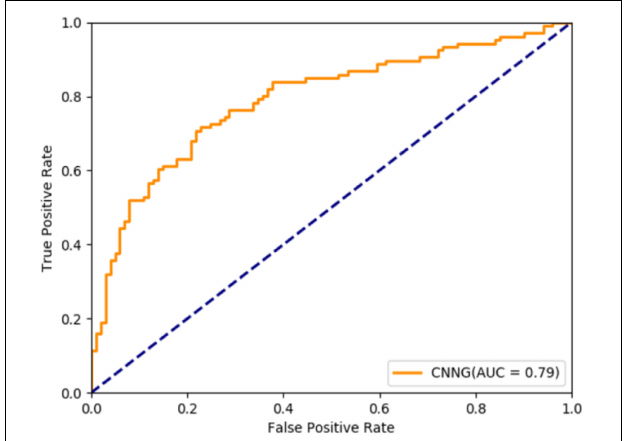
FIGURE 4 | Receiver operating characteristic (ROC) curve of CNNG